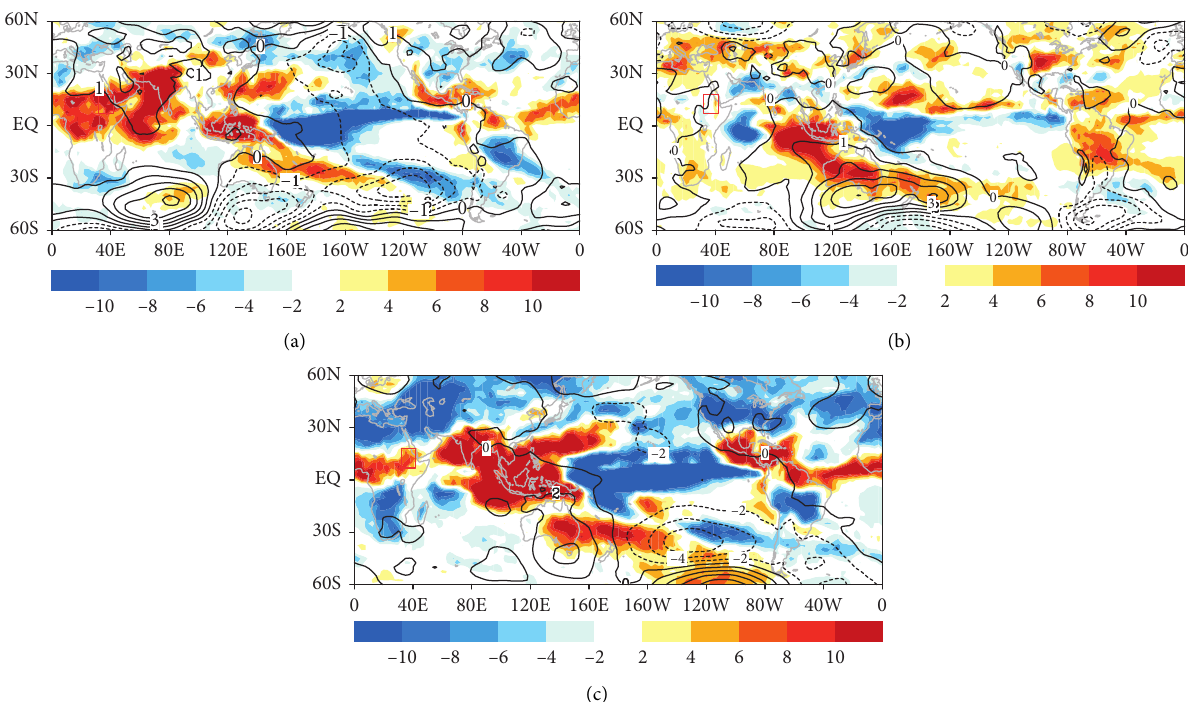
Figure 14: The difference of OLR (shaded in W m2 − 1 ) and SLP (contour in hPa) in JJAS (a) between El Nin ̃ o alone years and La Nin ̃ a alone years, (b) between pIOD alone years and nIOD alone years, and (c) between El Nin ̃ o and pIOD coexisting and La Nin ̃ a and nIOD coexisting years.